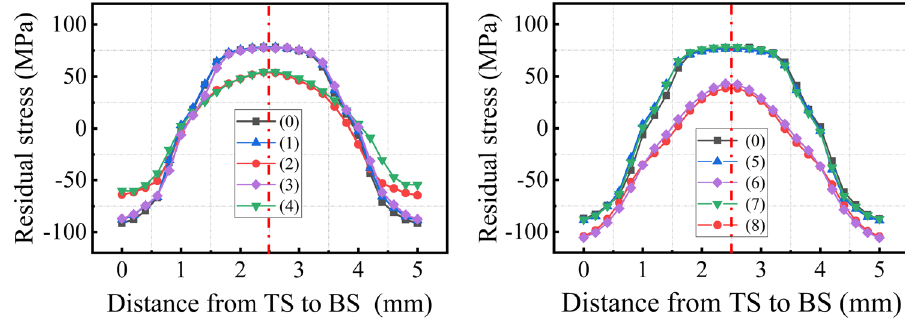
Figure 7: Symmetrical stress distribution in the thickness direction after